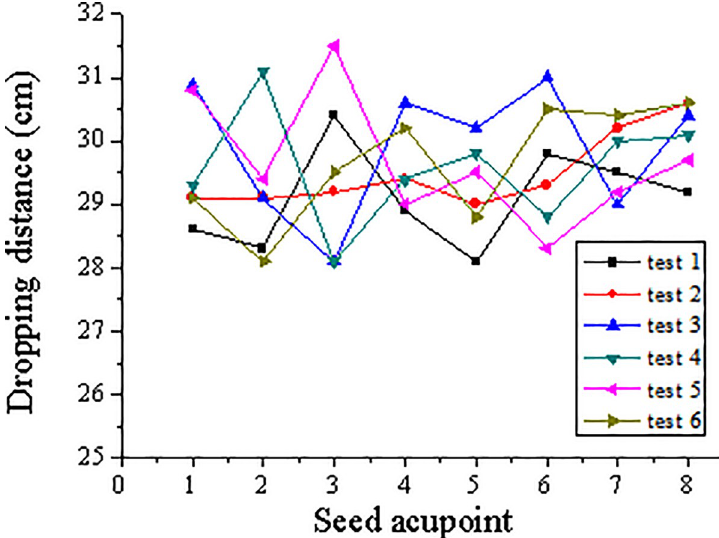
Fig 8. Precision positioning seeding experiment of corn under random disturbance